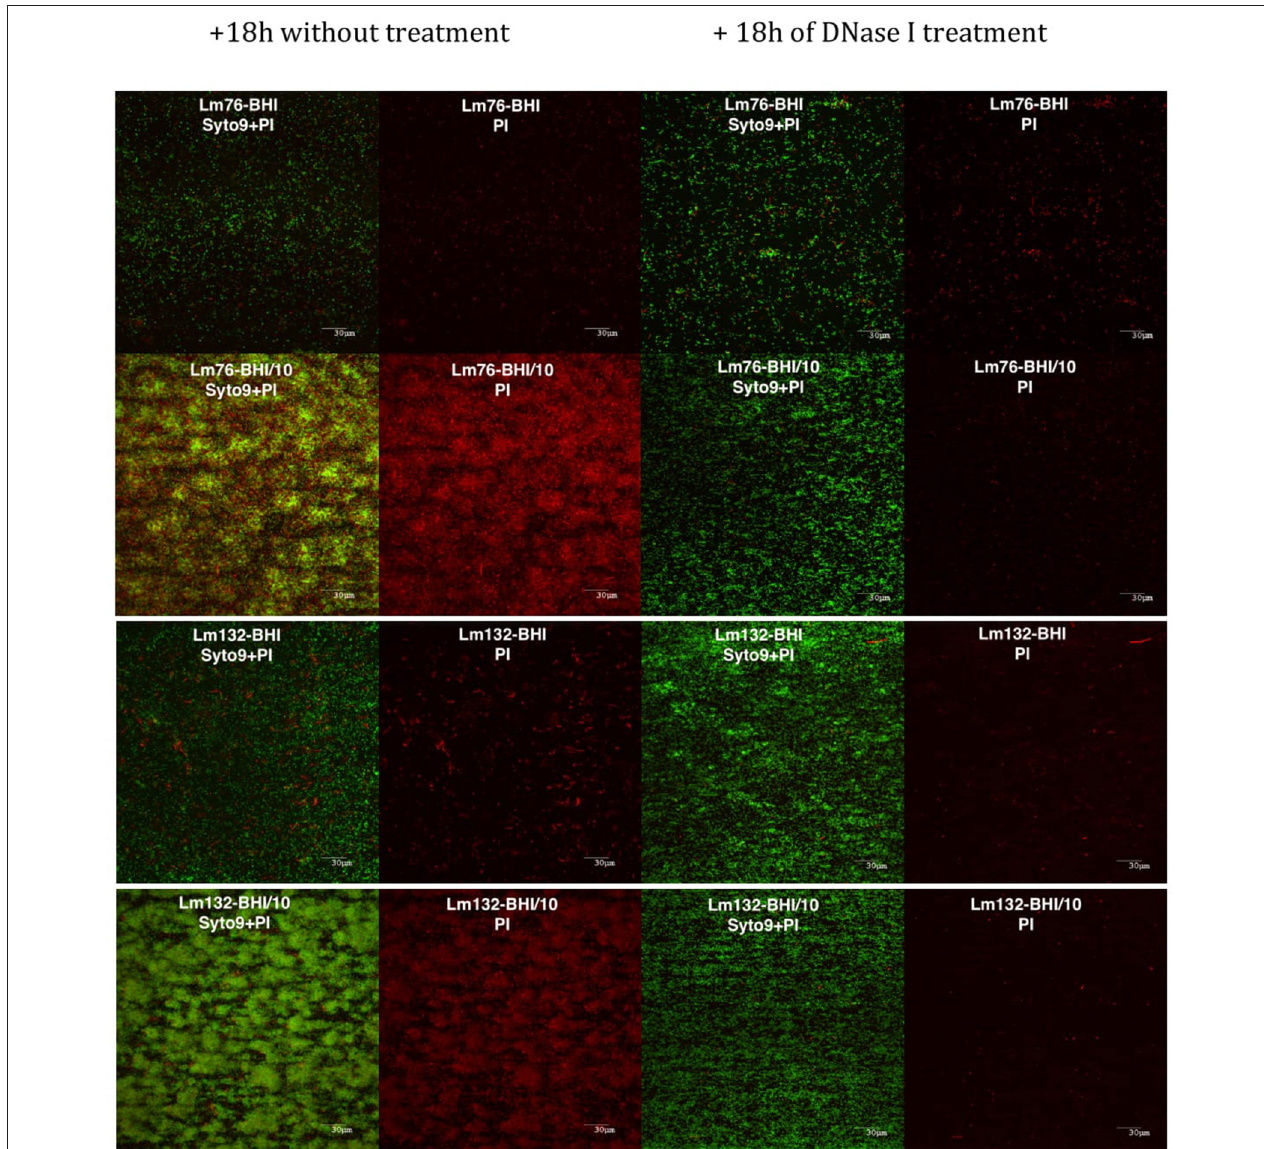
FIGURE 6 | Biofilm of Lm76 and Lm132 grown under BHI or BHI/10 medium as a control (right images) and BHI or BHI/10 containing 100 µ g/ml of DNase I (left images). All biofilms were stained with Syto9 and PI dyes after 18 h with DNase treatment or without treatment. The images show, from the left to the right, biofilm stained with Syto9 and PI without treatment (the two left images) and biofilm stained with Syto9 and PI after DNase treatment to show the decrease of e-DNA and dead/damaged